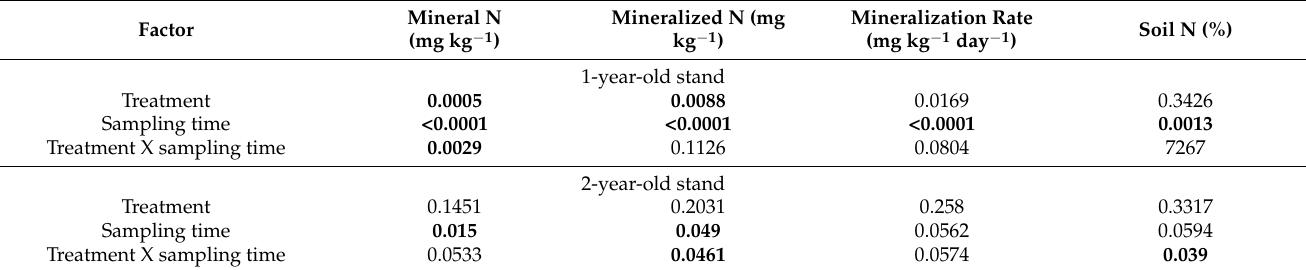
Table 5. Results of analysis of variance to test for significant nitrogen-addition treatment, sampling time, and interaction effects on soil mineral N, mineralized N, and N-mineralization rates in 1-year- old and 2-year-old intermediate wheatgrass stands. Totals are a sum of NO 3 − -N (0–15) and soil NH 4 + -N, respectively. Statistics were based on a randomized block design with 4 replicates of each treatment per block. Because stand ages were not able to be included in the randomization, statistics were performed separately for each stand